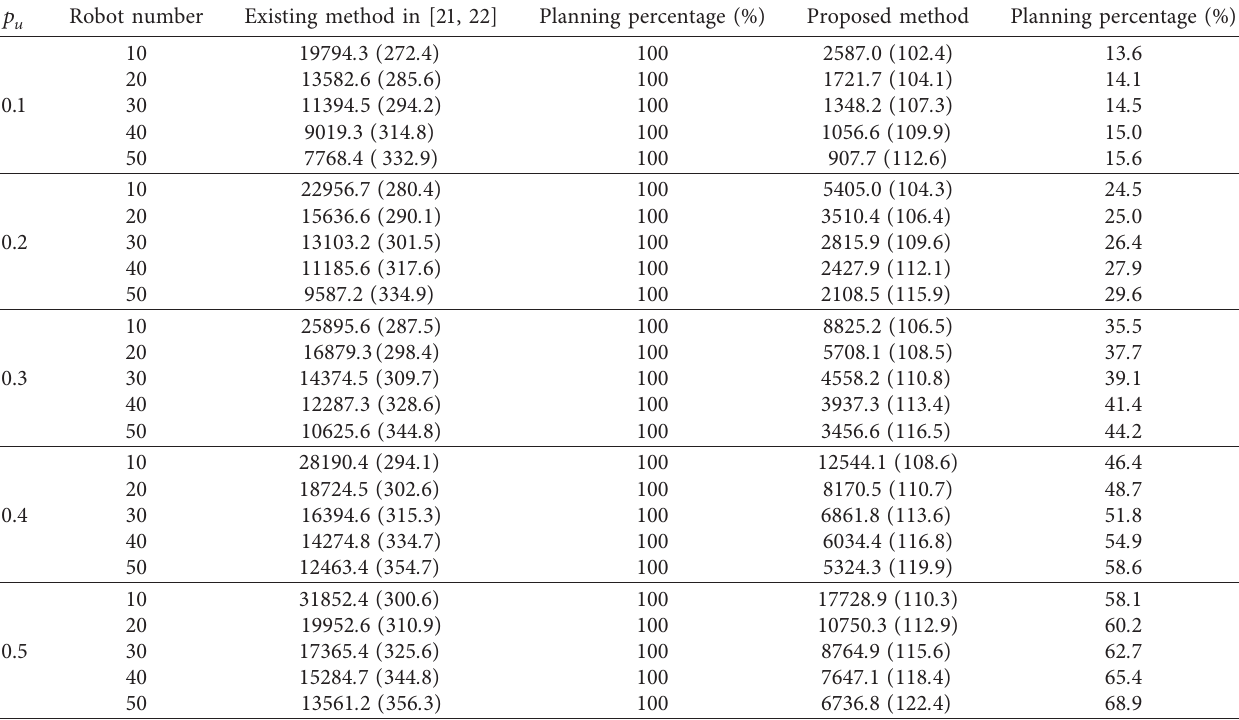
Table 3: Simulation results in a warehouse environment of 50 × 34 4-neighbor grids: number of planning (standard deviation).